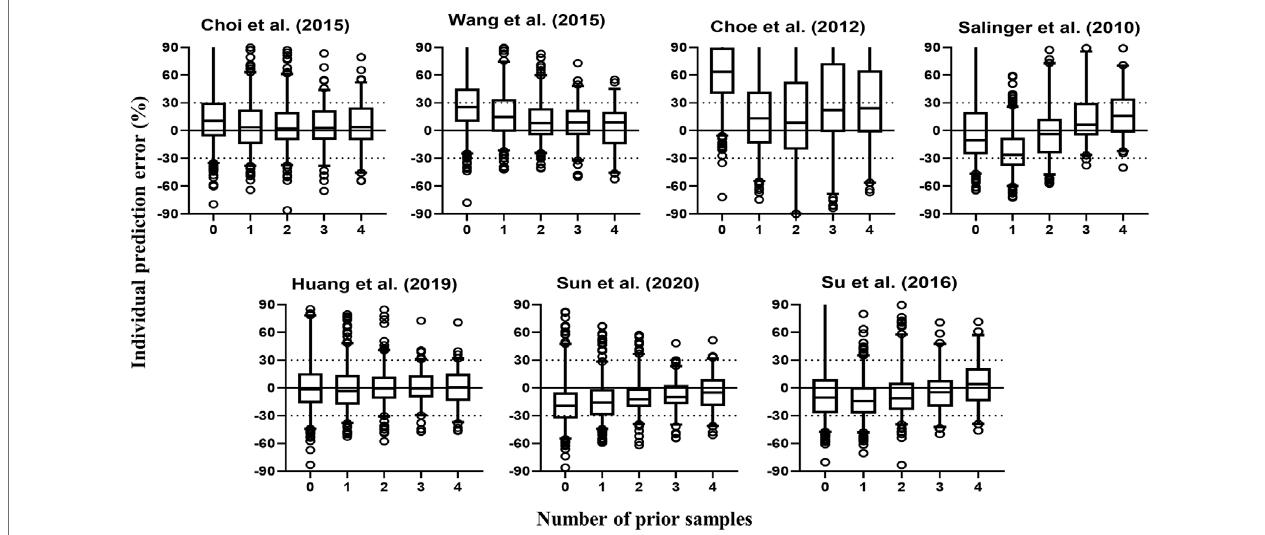
FIGURE3| Boxplotsofindividualrelativepredictionerror(IPE%)withBayesianforecastingforsevenpublishedpopulationpharmacokineticmodels(Salingeretal., 2010; Choe et al., 2012; Choi et al., 2015; Wang et al., 2015; Su et al., 2016; Huang et al., 2019; Sun et al., 2020) in different scenarios (0 represents prediction without prior information and 1-4 represents with prior one to four observations, respectively). In scenario n, prior n observations were used to estimate the individual prediction and it was then compared with the corresponding observation.